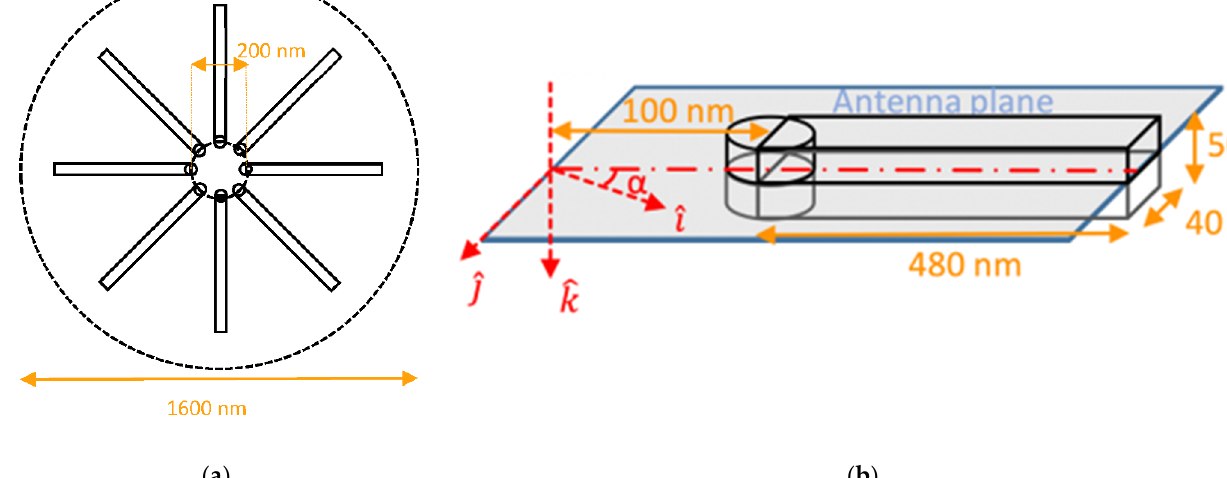
Figure 3. Antenna plane with the eight arms in addition to the simulation volume cross-section with a diameter of 1600 nm.